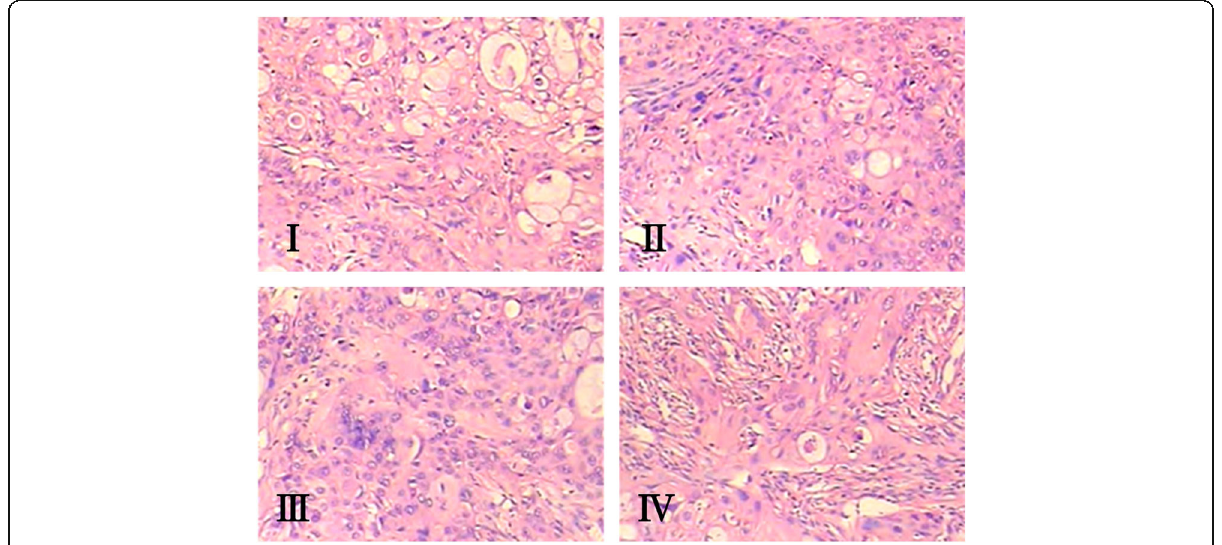
Fig. 3 Histopathological examinations by H&E (B, 200 ×). I: Control group, II: Elemene 20 mg/kg group, III: Elemene 40 mg/kg group, IV: Elemene 60 mg/kg